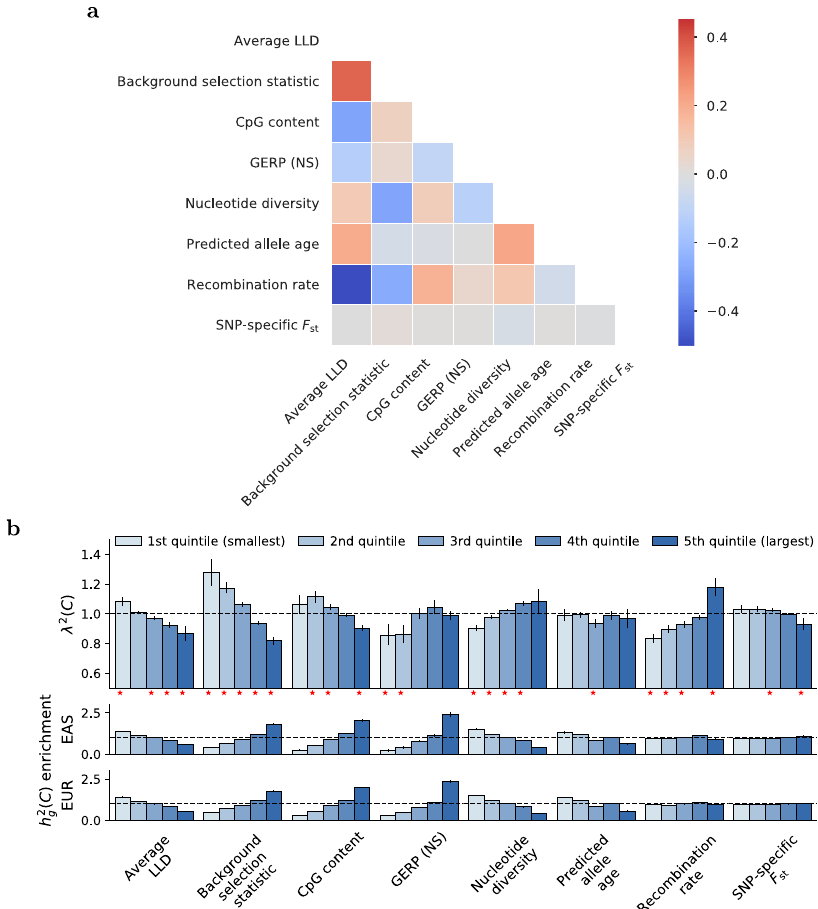
Fig. 2 S-LDXR results for quintiles of 8 continuous-valued annotations across 31 diseases and complex traits. a We report correlations between each continuous-valued annotation; diagonal entries are not shown. Numerical results are reported in Supplementary Data 1. b We report estimates of the enrichment/depletion of squared trans-ethnic genetic correlation ( λ 2 ( C )), as well as population-speci fi c estimates of heritability enrichment, for quintiles of each continuous-valued annotation. Results are meta-analyzed across 31 diseases and complex traits. Error bars denote ± 1.96 × standard error of the meta- analyzed λ 2 ( C ). P-values are obtained from the standard normal distribution. Red stars ( ⋆ ) denote two-tailed p < 0.05/40. Numerical results are reported in Supplementary Data